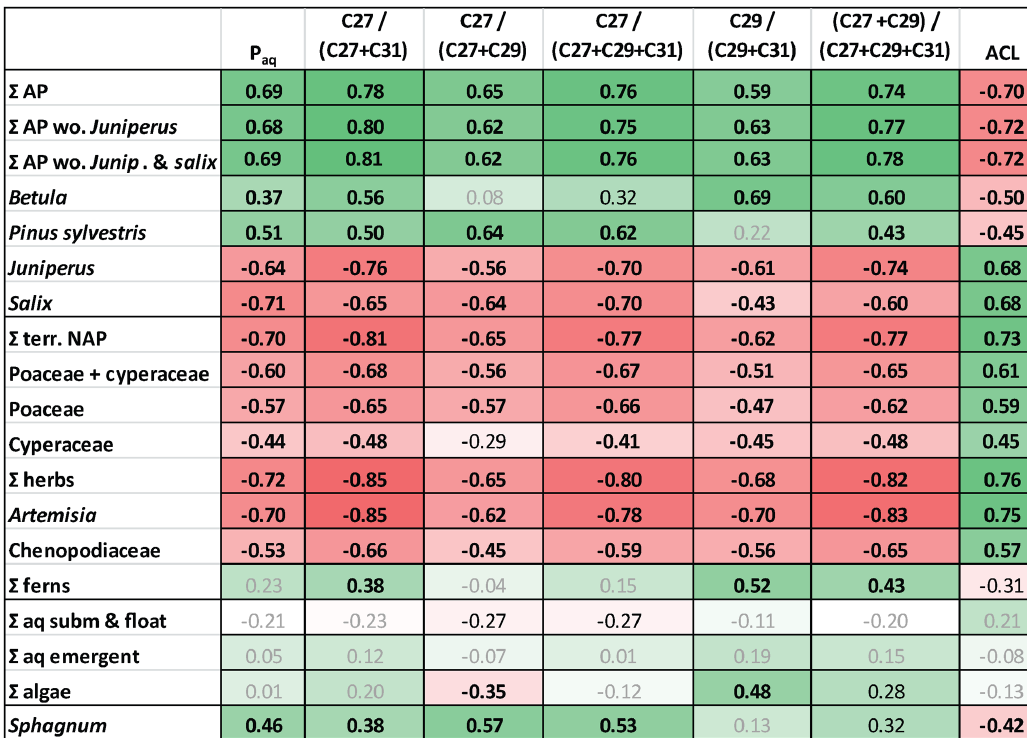
Figure 6. Heat map table showing Pearson correlation coefficients between pollen percentages and n -alkane ratios. Data have been z - transformed before correlation. Bold black numbers: p< 0 . 01. Black numbers: p< 0 . 05. Positive correlations in green and negative corre- lations in red. Intercorrelation between relative abundances of pollen and n -alkane ratios are in Tables S3 and S5 in the Supplement. AP: arboreal pollen. Terr. NAP: terrestrial non-arboreal pollen. (cid:54) other herbs: NAP without Poaceae and